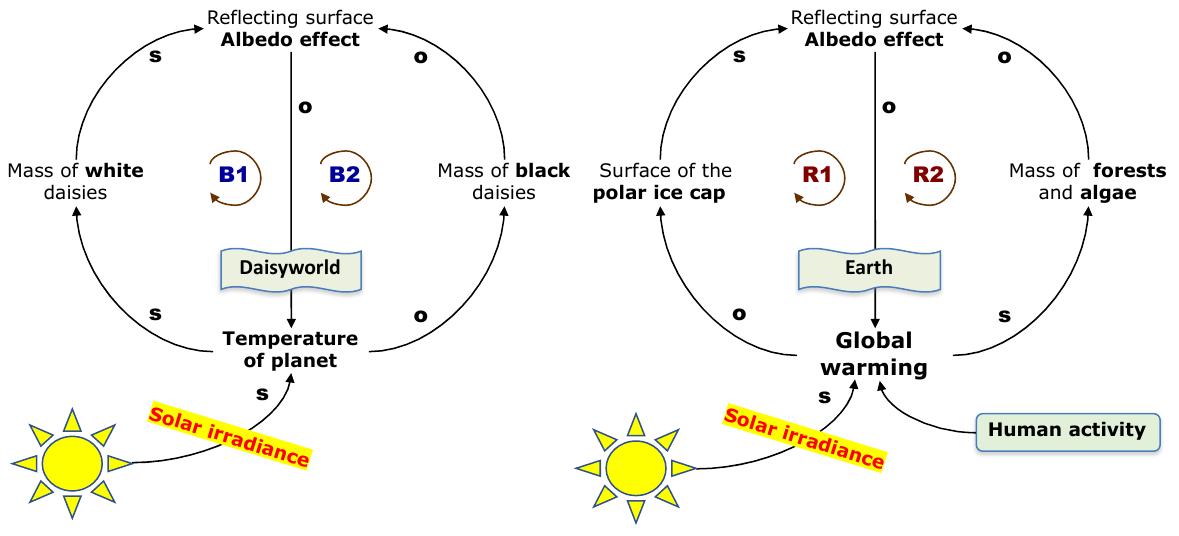
Figure 2. Comparison of Daisyworld and Earth.